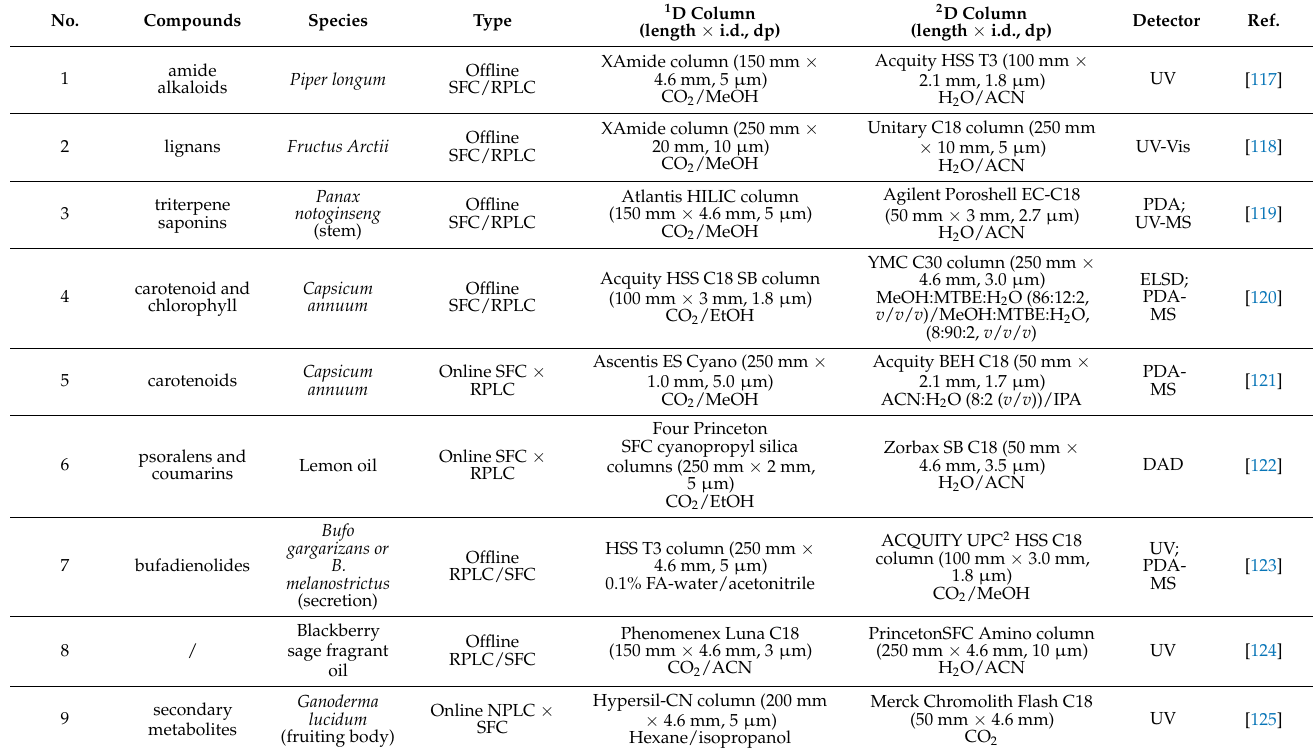
Table 2. Application of SFC in series with other chromatography techniques in the analysis of natural